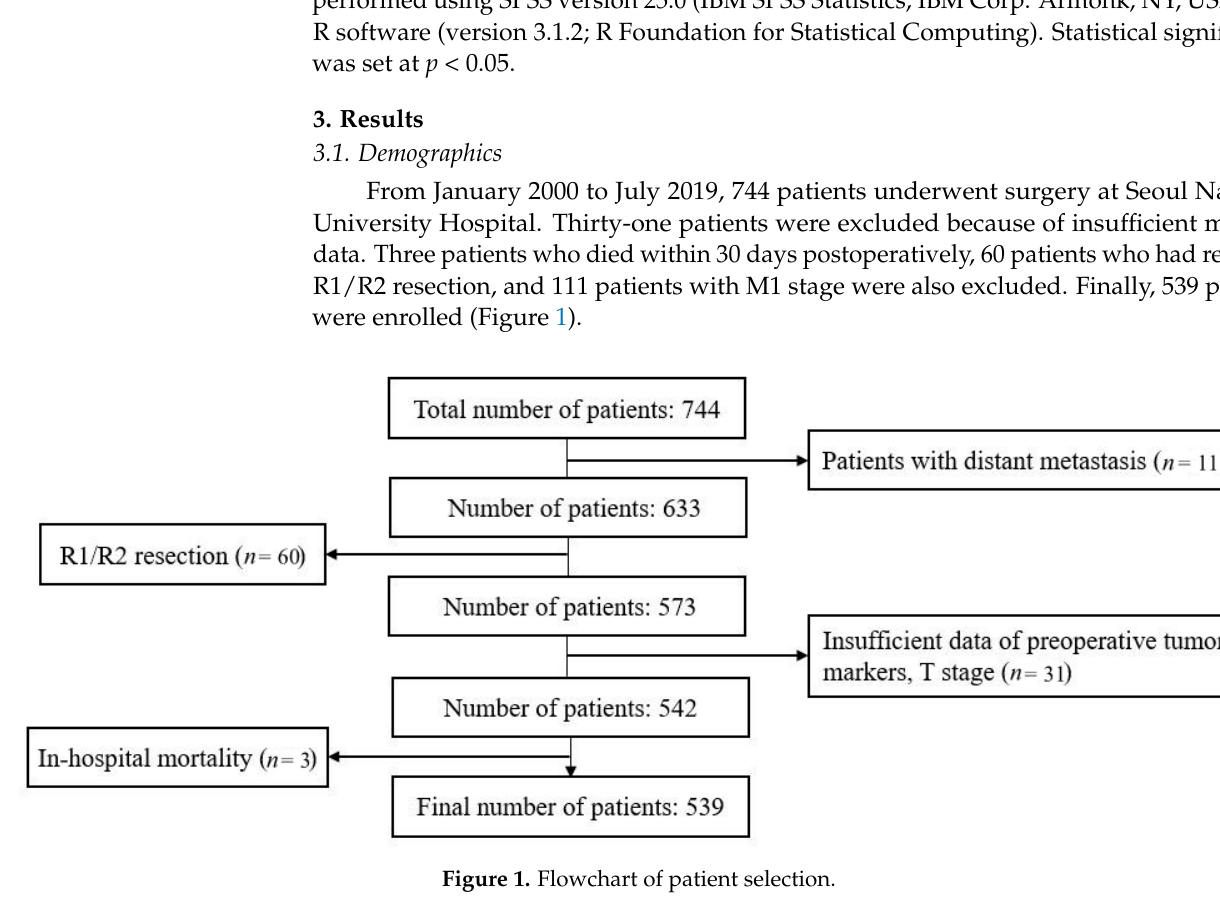
Figure 1. Flowchart of patient selection.